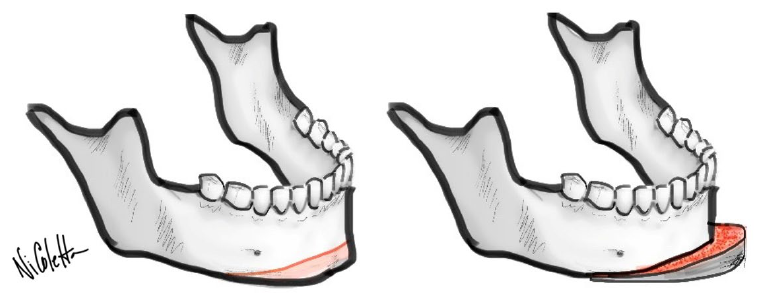
Figure 2. Sliding genioplasty-osteotomy pattern for correction of microgenia, Nikoletta Vargas DMD, MS, PhD.